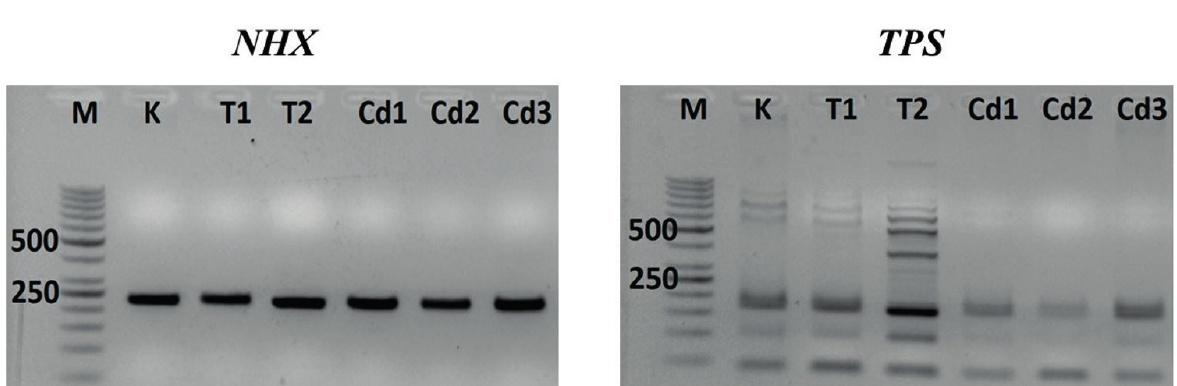
Figure 3. 2% agarose gel electrophoresis results of PCR analysis of isolated leaf samples of V. turcica using degenerate NHX (left) and TPS (right) primers; K: control; T1: 1000 ppm NaCl treated leaves; T2: 2000 ppm NaCl treated leaves; Cd1: 5 ppm Cd treated leaves; Cd2: 25 ppm Cd treated leaves; Cd3: 50 ppm Cd treated leaves, M: 50 bp DNA ladder.